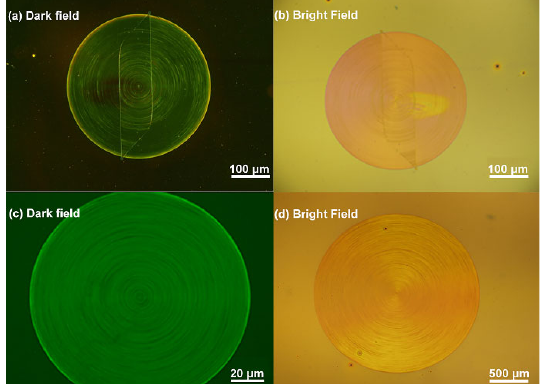
Figure 3. Optical microscopic images of the circular periodic structures. ( a ) and ( c ): Dark ‐ field optical micrographs. ( b ) and ( d ): Bright ‐ field optical micrographs. micrographs. ( b ) and ( d ): Bright-field optical